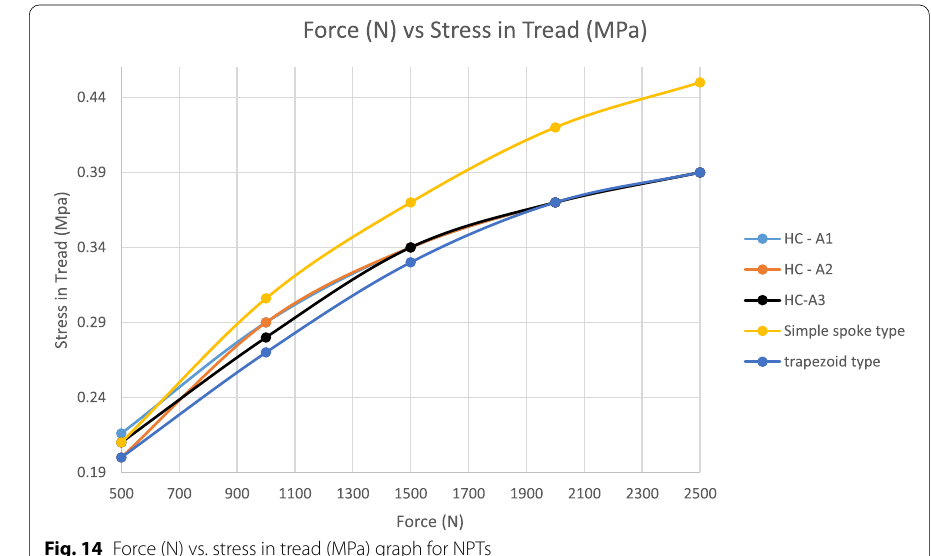
Fig. 14 Force (N) vs. stress in tread (MPa) graph for